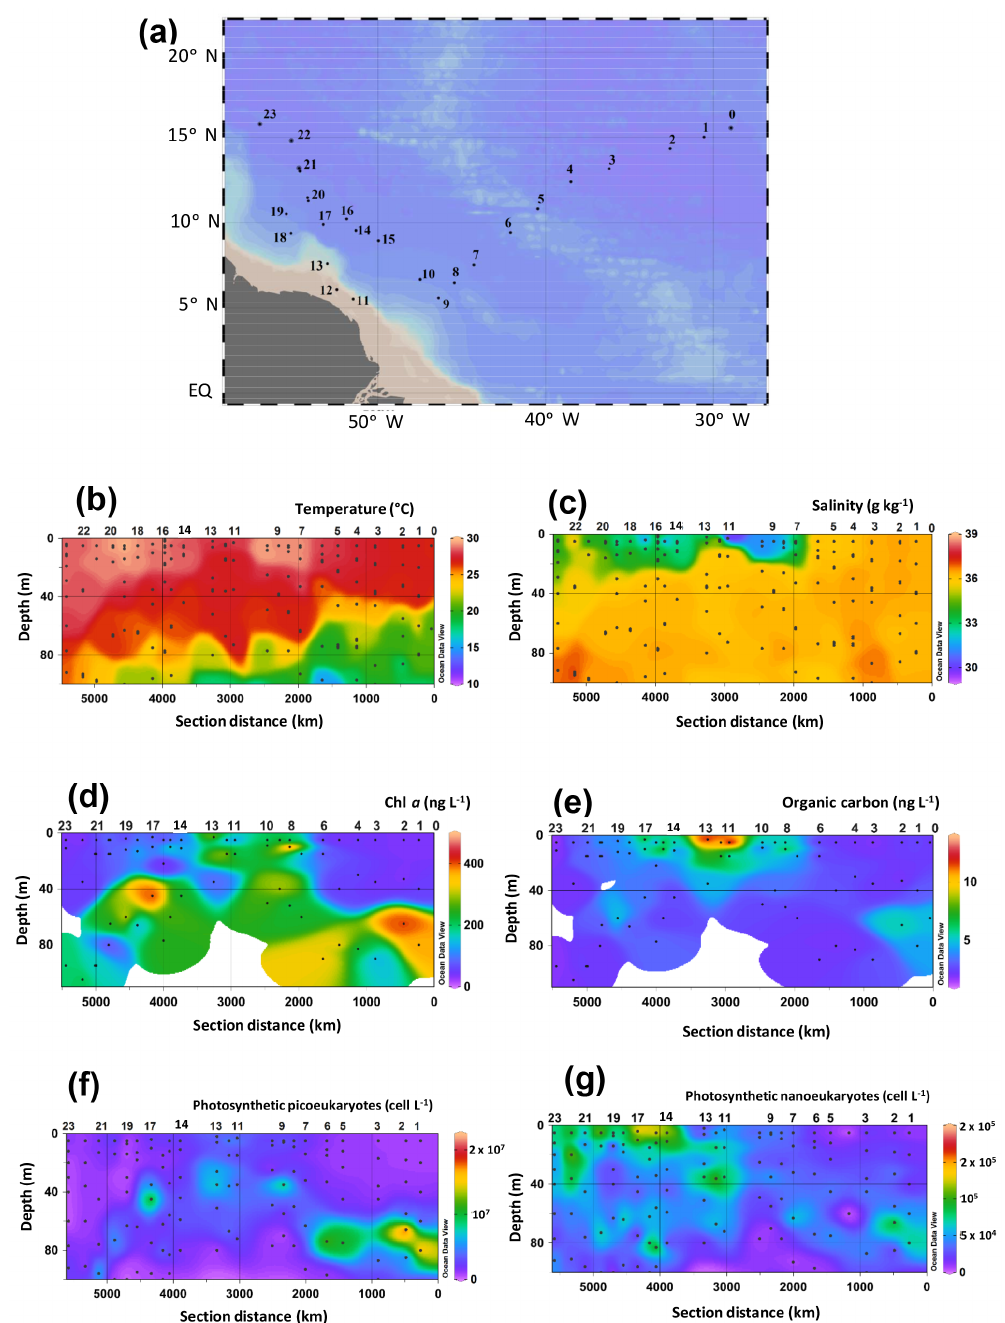
Figure 1. HCC cruise track in the western tropical North Atlantic Ocean, physical seawater properties, and biological parameters. (a) Map of the sampling stations. Spatial distribution of (b) temperature, (c) salinity, the concentration of (d) Chl a , (e) organic carbon concentrations, and the abundance of photosynthetic (f) picoeukaryotes and (g) nanoeukaryotes. Temperature, salinity, as well as the concentrations of Chl a and organic carbon have also been published by Bale et al. (2018). Data were plotted using ODV software using kriging for interpolation between data points (Schlitzer, 2002). Dots represent the depth at which SPM was